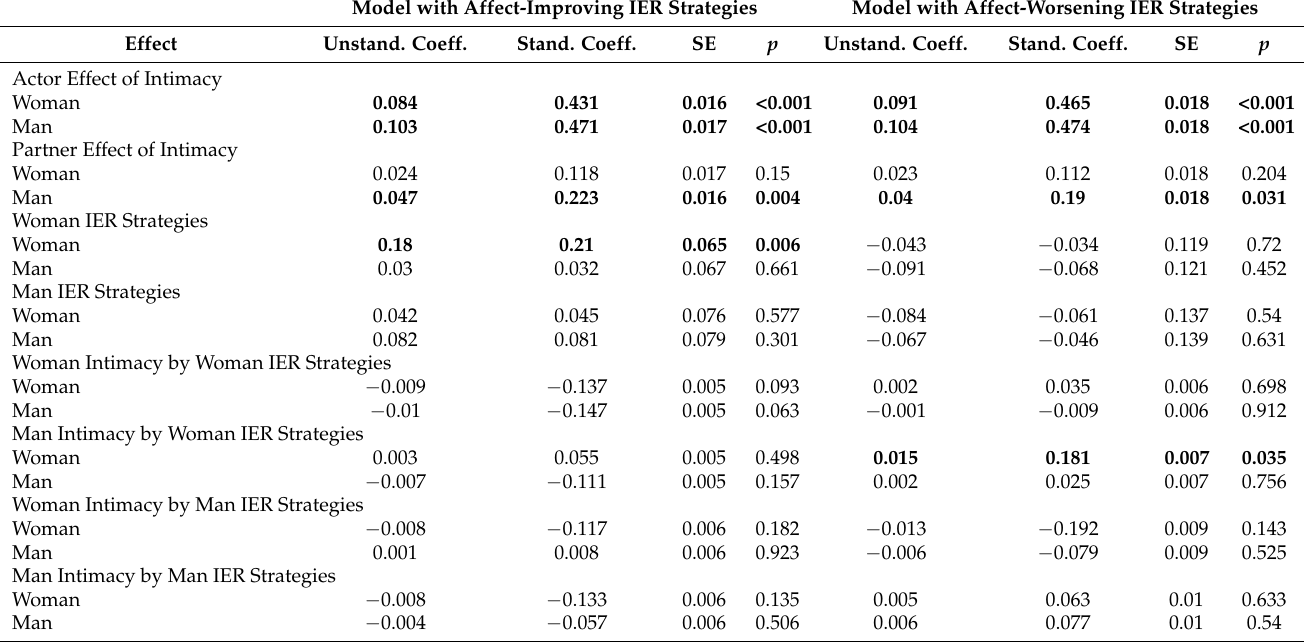
Table 4. Model predicting couple satisfaction from intimacy, moderated by both women’s and men’s interpersonal affect-improving and affect-worsening strategies. Model with Affect-Improving IER Strategies Model with Affect-Worsening IER Strategies Effect Unstand. Coeff. Stand. Coeff. SE p Unstand. Coeff. Stand. Coeff. SE